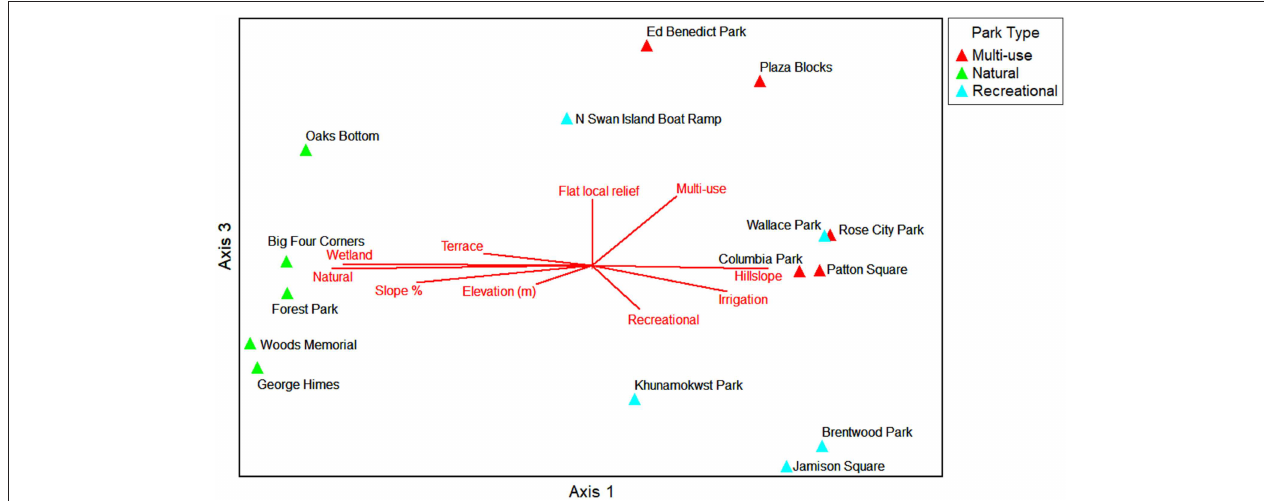
FIGURE 7 | NMS ordination Axes 1 and 3 for the parks in species space. Environmental variables that are strongly related to the individual ordination axes ( r 2 > 0.2) are shown as joint plots (radiated red lines).